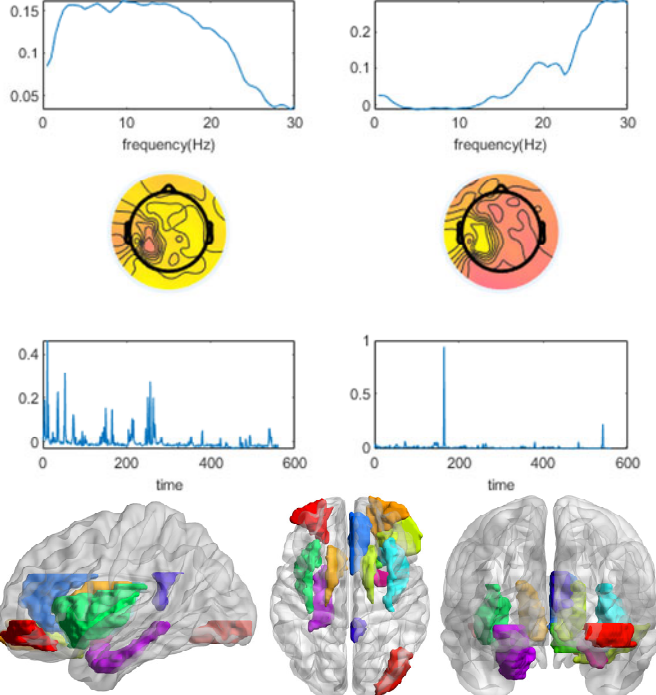
Figure 7. The CMTF results for subject 13 demonstrate the temporal signature s r , spectral signature f r , and spatial (channel) signature c r of 2 sources in the EEG domain and activation of the ROI associated with both winning and losing stimuli. Table 2. Partial activated ROIs of all subjects of both winning and losing stimuli.